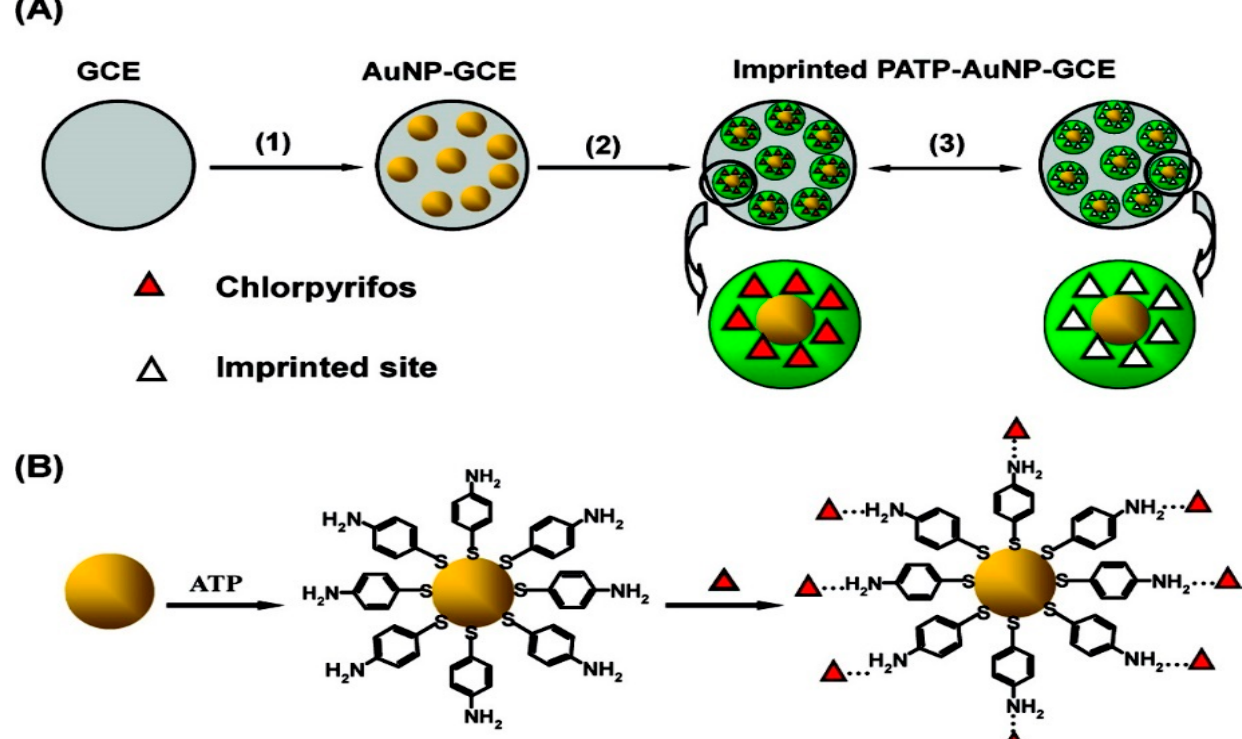
Figure 10. ( A ) Working principle of the imprinted PATP–AuNP–GCE: (1) AuNPs are electrodeposited on the surface of the GCE; (2) ATP electropolymerisation on the AuNP–GCE surface; (3) CPF removal/rebinding on the imprinted sites of the imprinted PATP–AuNP–GCE. ( B ) The graphic map for the adsorption of the ATP molecule on the surface of AuNP, followed by self-assembly of CPF at the ATP-modified AuNP–GCE. Reprinted with permission from [193]. Copyright © 2021, American Chemical Society. Table 1. Sensitivity/LOD comparison of the reviewed nanocomposites sensing platform.